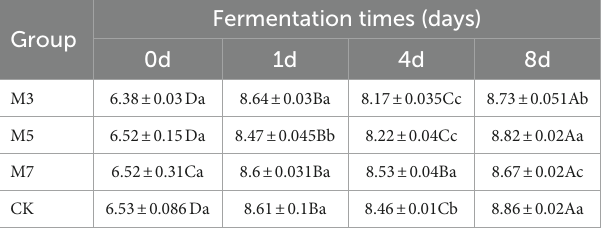
TABLE 3 Changes of total viable bacteria number during fermentation.